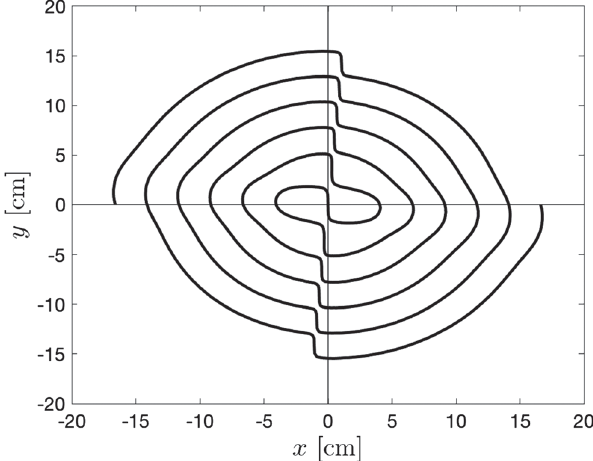
FIG. 4. 3 GHz TM (a) The cavity shapes, r ð